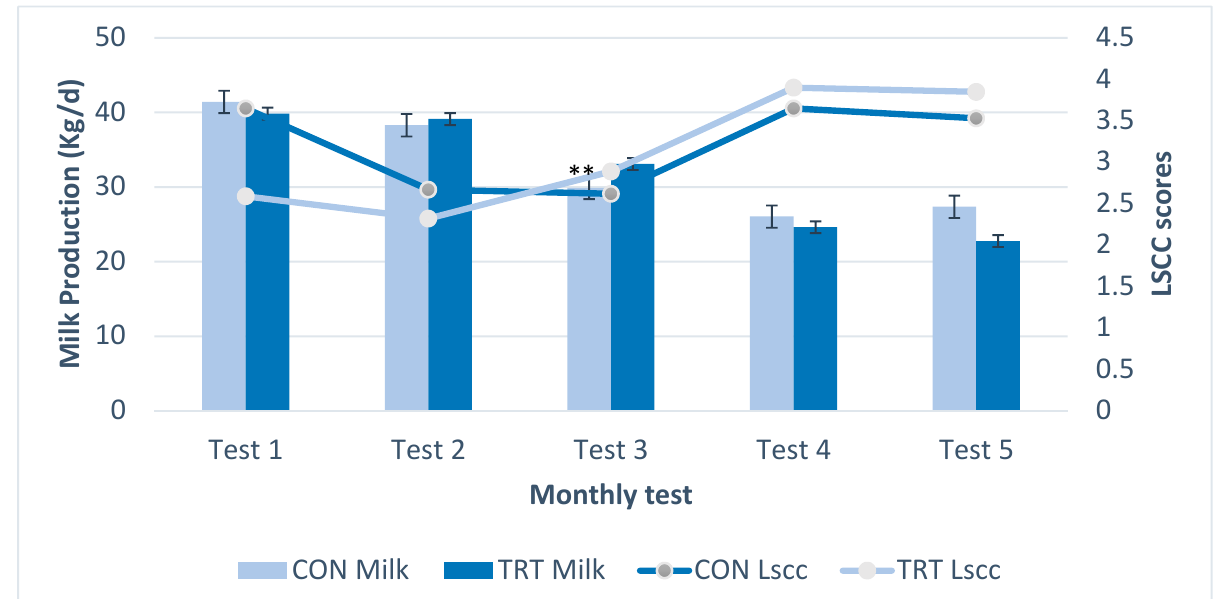
Figure 1. Distribution of milk production and linear somatic cell score (LSCC) across the monthly milk test days among cows in treatment (TRT; no headlocks) and control (CON; regular headlock) groups. ** denotes a statistically significant difference.